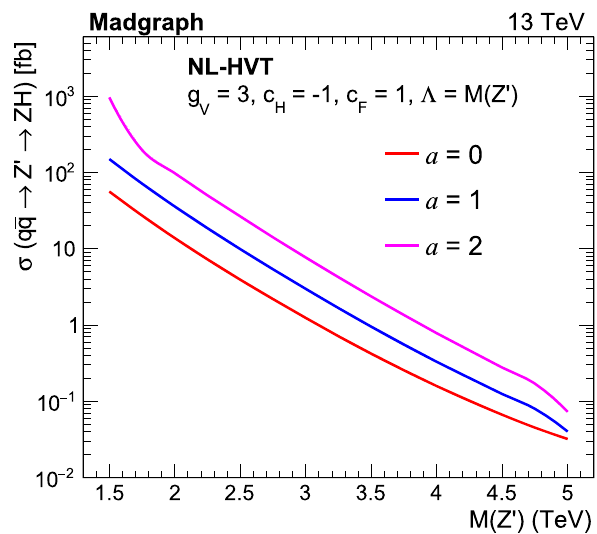
Fig. 2 Z (cid:2) resonance cross sections for the DY production mode after a non-local modification, as a function of the pole mass M ( Z (cid:2) ) . The non-locality scale Λ NL in Eq.3 has been set at the pole mass M ( Z (cid:2)